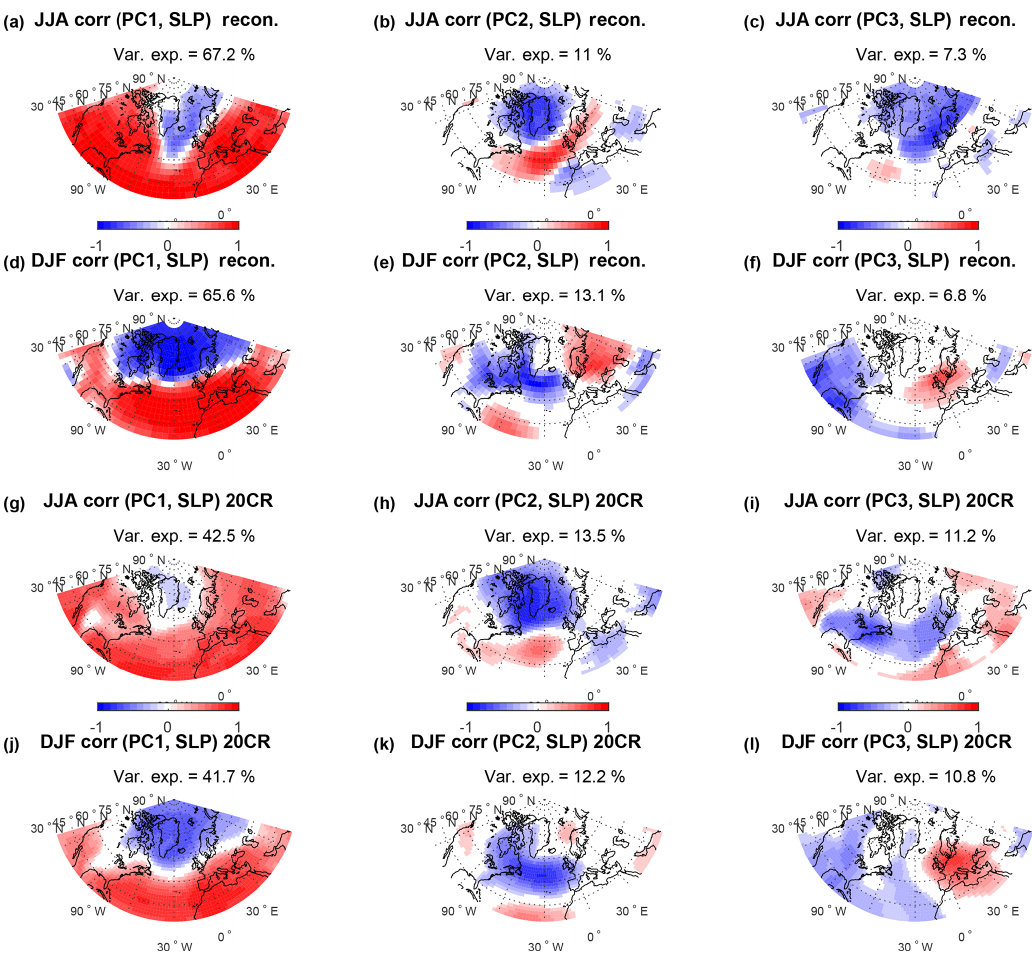
Figure 6. (a–c) Regression of the first three reconstructed PCs of SLP on reconstructed (eight ice cores) JJA SLP, which corresponds to the reconstructed EOF patterns. Panels (d) – (f) are the same as (a) – (c) but for DJF. These plots, with the addition of the plots for DJF reconstructed (eight ice cores) from the winter-centered annual mean ice core data, are shown in Fig. S10, as well as corresponding plots for sum50, win50 and win100 shown in Fig. S11. (g) – (i) Regression of the first three 20CR PCs of SLP on 20CR JJA SLP, which corresponds to the EOF patterns. Panels (j) – (l) are the same as (g) – (i) but for DJF. These plots for 20CR data are also shown in Fig. S12, as well as corresponding plots for sum50, win50 and win100 shown in Fig. S13. The time period for all plots is 1851–1970. Data only shown for p < 0 .